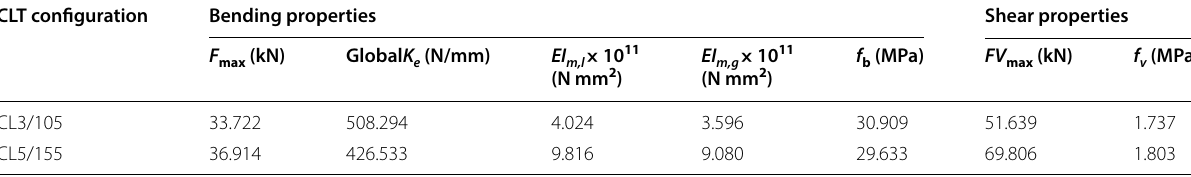
Table 9 Properties comparison between 3-layer CLT and 5-layer CLT CLT configuration Bending